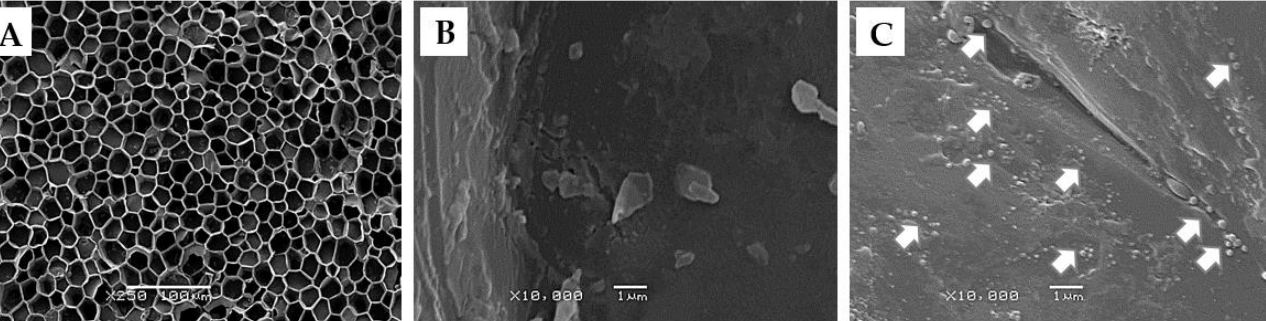
Figure 2. FTIR spectra of unmodified cork (straight lines) and AgLNP-coated cork (dash line). Otherwise, SEM images showed that the AgLNP were configured in agglomerated spherical shapes on the cork surface, thus confirming their successful embedding (Figure 3).